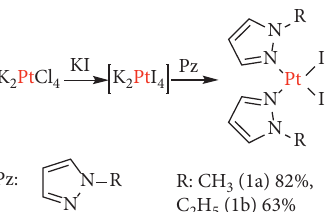
Figure 1: Synthesis of platinum(II) diiodido